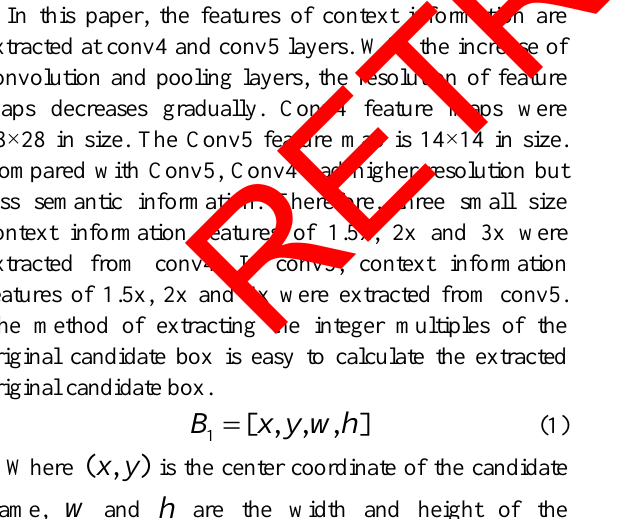
Figure 3. Contextual information of conv5 If the coordinates of the upper left and lower right corner of the original candidate